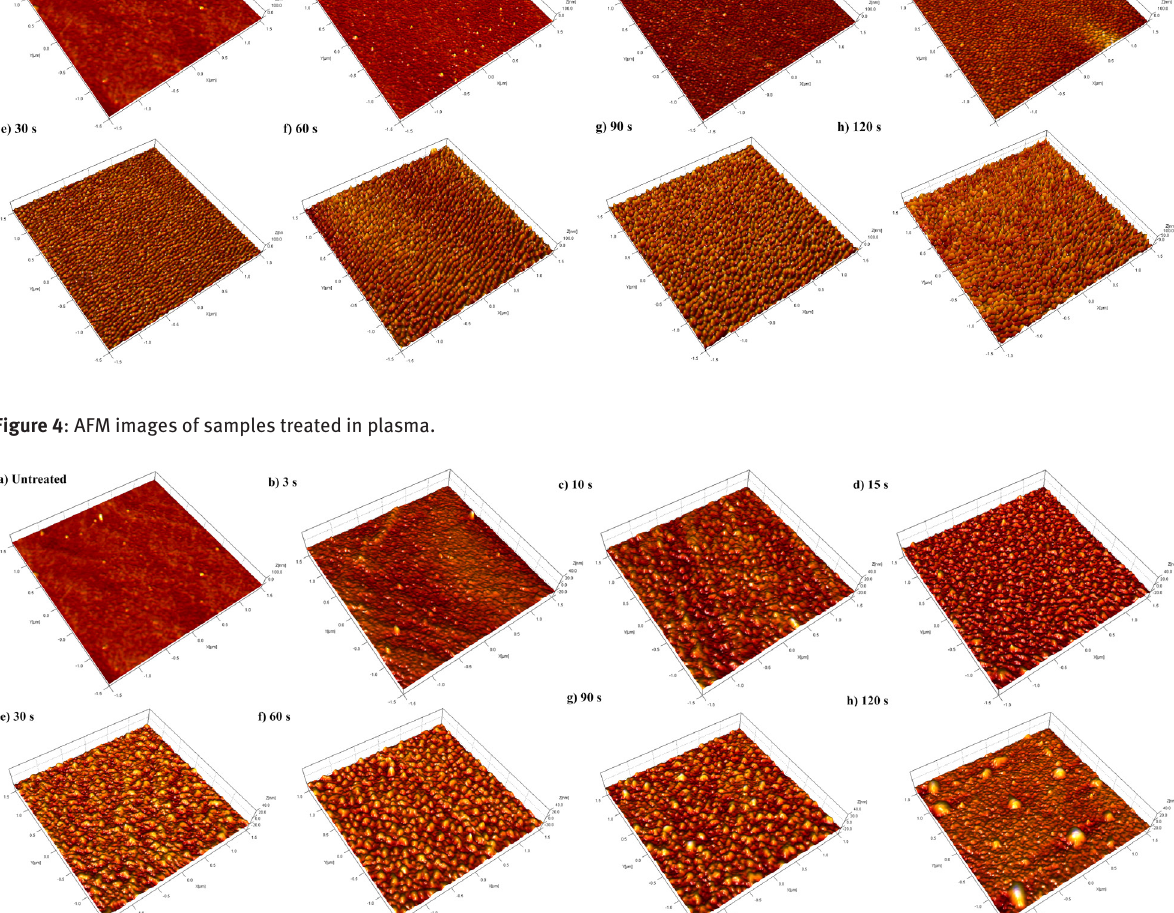
Figure 5 : AFM images of samples treated in